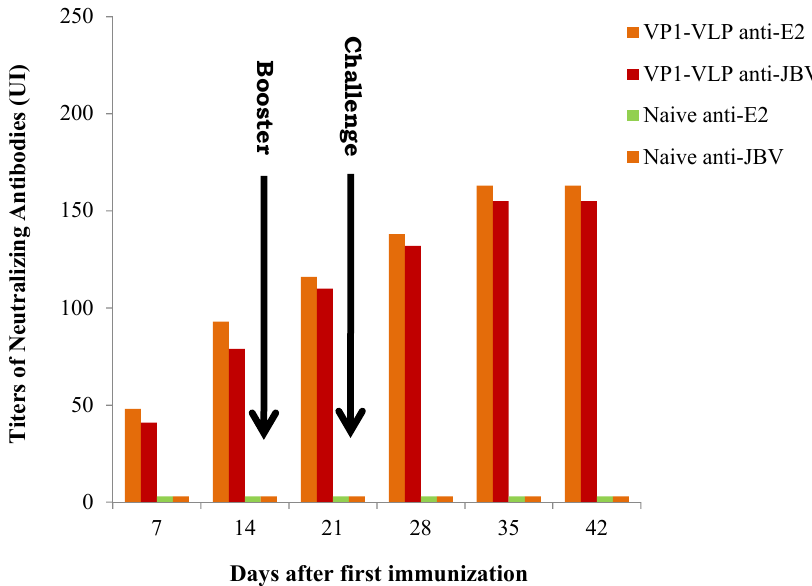
Figure 3. Production and titers of specific neutralizing antibodies in mice vaccinated with VP1-VLP. VP1-VLP anti-E2 represents mice group vaccinated with a prime-boost regimen at days 0 and 15, then challenged at day 22 with CVB4E2 strain. VP1-VLP anti-JBV represents mice group vaccinated with a prime-boost regimen at days 0 and 15, then challenged at day 22 with CVB4JBV strain. Titers of neutralizing antibodies produced in mice sera were measured at different times post immunization. Naïve control mice represent the negative control.